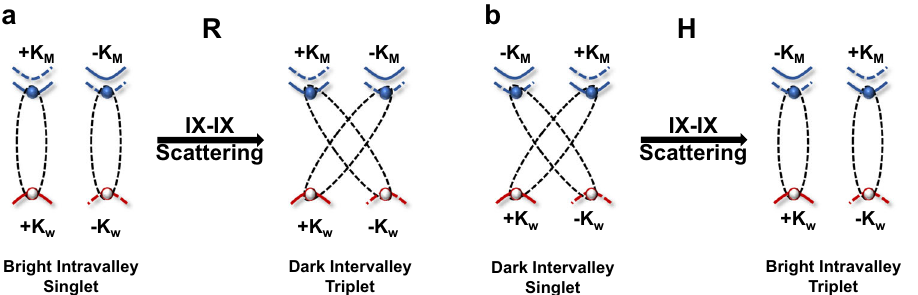
Fig. 4 IX – IX exchange interaction for R- and H-type heterostructures. a Depiction of R-type decay channel where the IX – IX exchange interaction can scatter bright intravalley singlet IXs to dark intervalley triplet IXs. b Depiction of H-type decay channel where the IX – IX exchange interaction can scatter dark intervalley singlet IXs to bright intravalley triplet